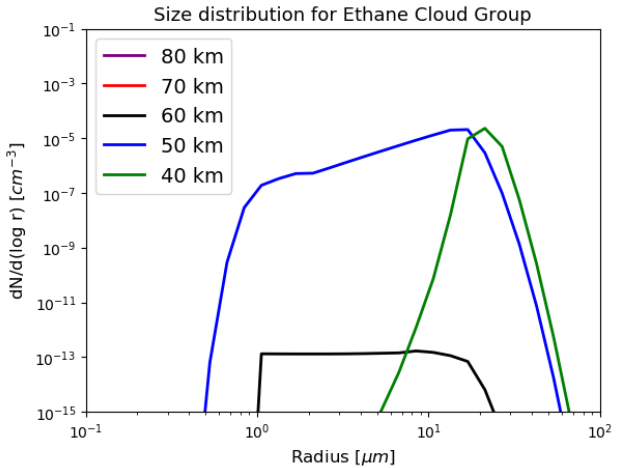
Figure 2. Size distributions at various altitudes of the ethane particles. The low volatility of the ethane vapor pressure at Titan’s stratospheric temperatures allows for efficient condensation growth of the ice particles (similar to methane).